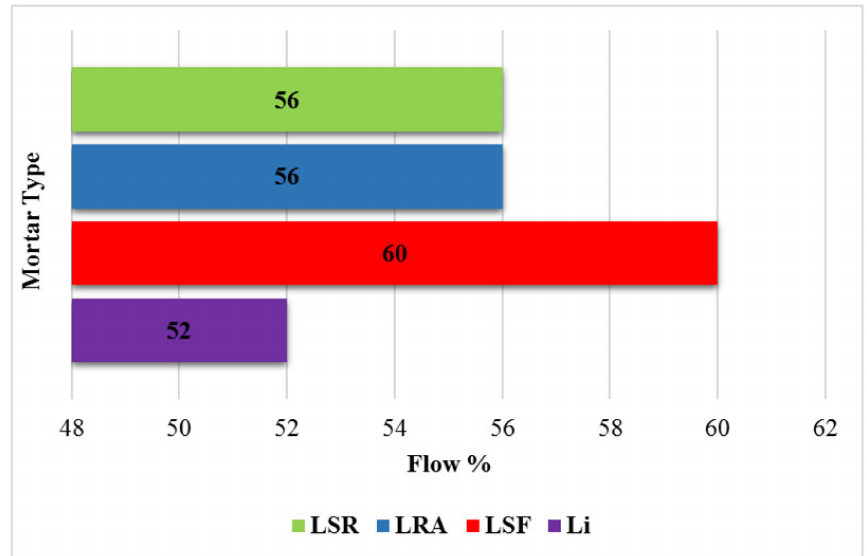
Figure 7. Workability of lime and lime composite